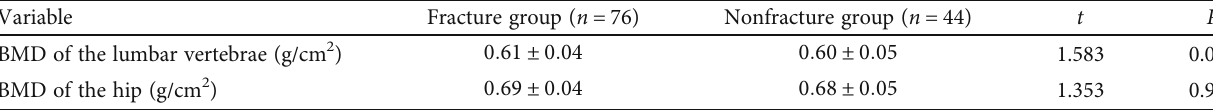
Table 2: Comparison of biochemical indexes of bone metabolism between the two groups.